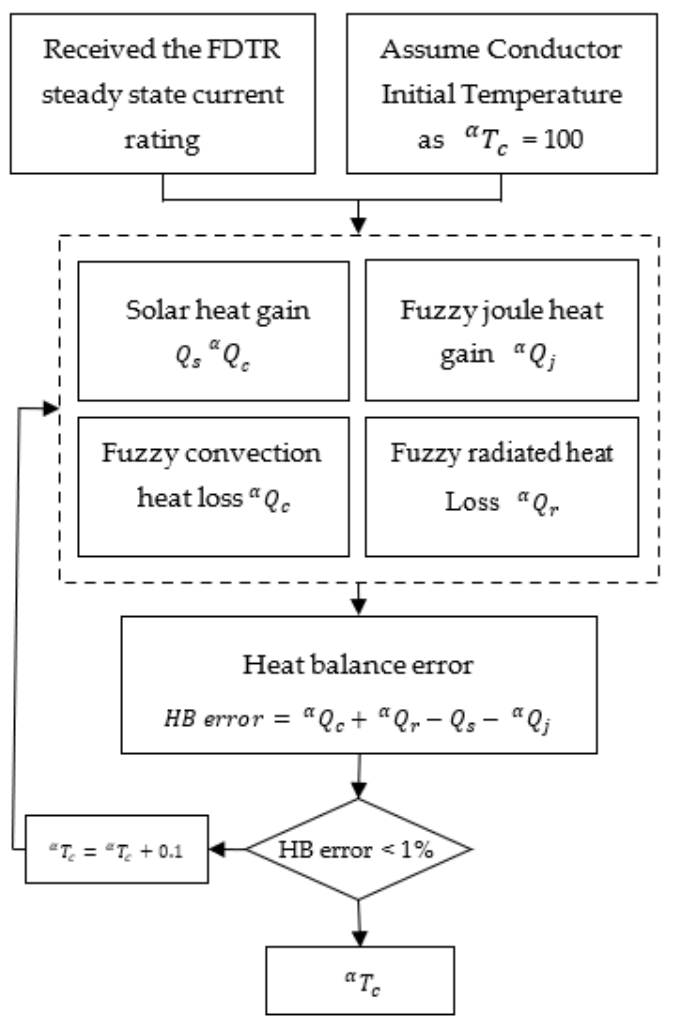
Figure 3. Conductor temperature estimation via an iterative process.